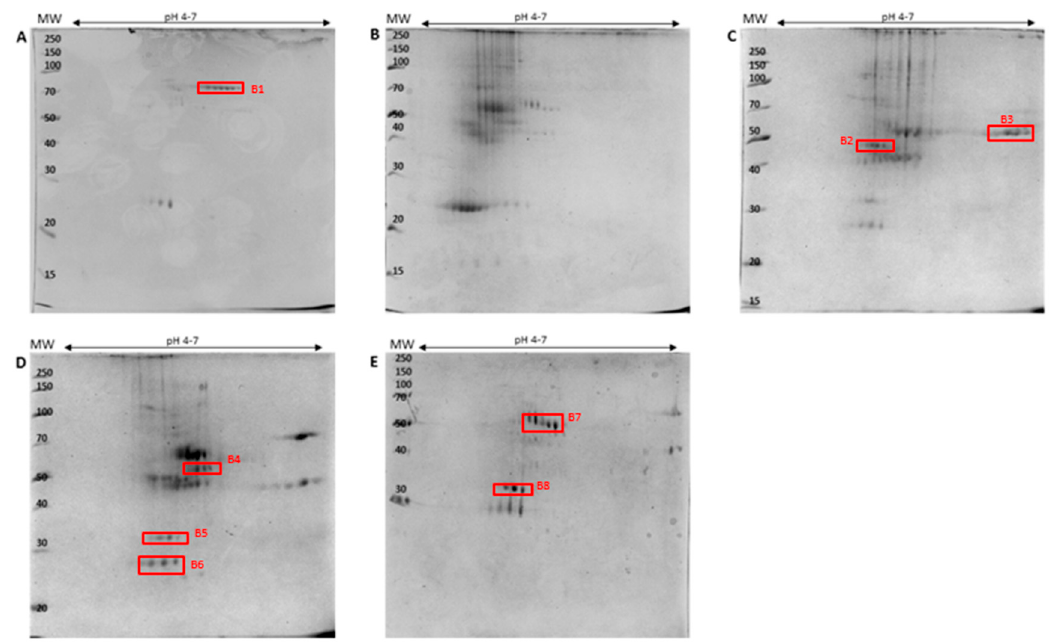
Figure 2. Comparative 2D-SDS-PAGE analysis for ergosterol-treated Arabidopsis thaliana PM-associated extracts. Proteins were precipitated with acetone, and 100 µg total protein was loaded onto immobilized pH gradient (IPG) strips, pH 4–7, for isoelectric focusing (IEF). The protein regulation differences are shown for A = control, and B = 0 h -, C = 6 h -, D = 12 h -, and E = 24 h-treated samples. The red blocks (B1–B8) indicate the protein spots excised for LC-MS/MS identification.